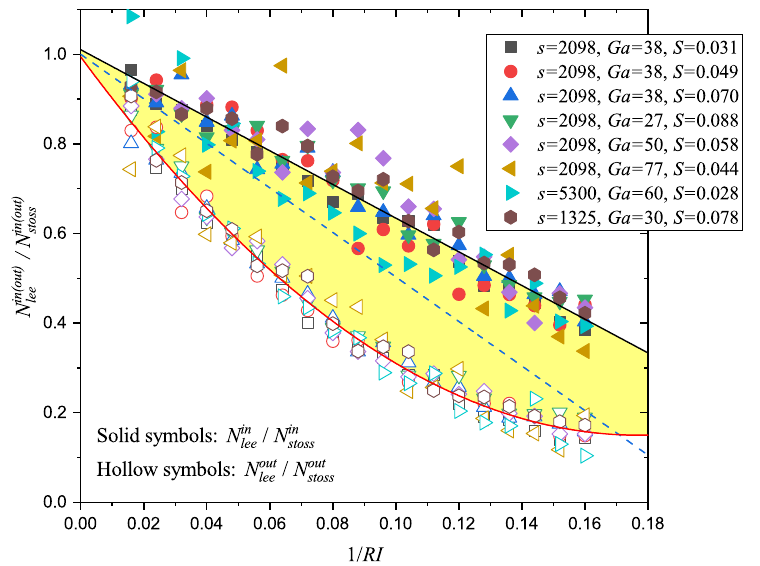
( out ) ( out ) Figure 6. N in / N in varies with RI , where N in stoss lee (take-off) particle number at the lee slope and that at the stoss slope. The black line is a linear fit of N in / N in . The red line is a quadratic polynomial fit of N out stoss lee for all the data. The bright yellow shade highlights the difference between the impact particle results and the take-off particle results, reflecting the influence from non-monotone